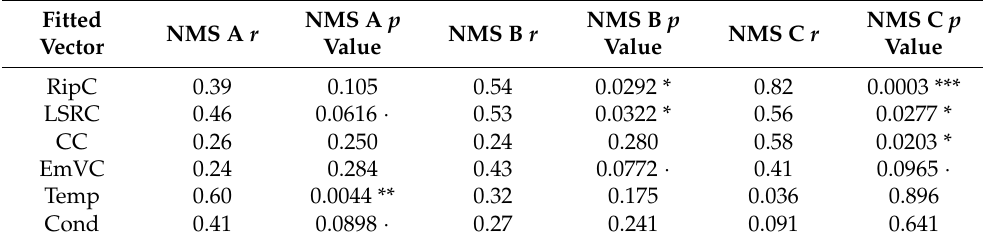
Table 5. Correlation coefficients ( r ) and p -values for fitted vectors in NMS bi-plots produced from permutation procedure ( n = 9999 permutations). See Tables 3 and 4 for explanation of variable abbreviations. See Figure 3 for explanation of each NMS bi-plot (i.e., A, B and C). Significance codes: ‘***’ p <0.001; ‘**’ p <0.01; ‘*’ p <0.05; ‘ · ’ p <0.1.